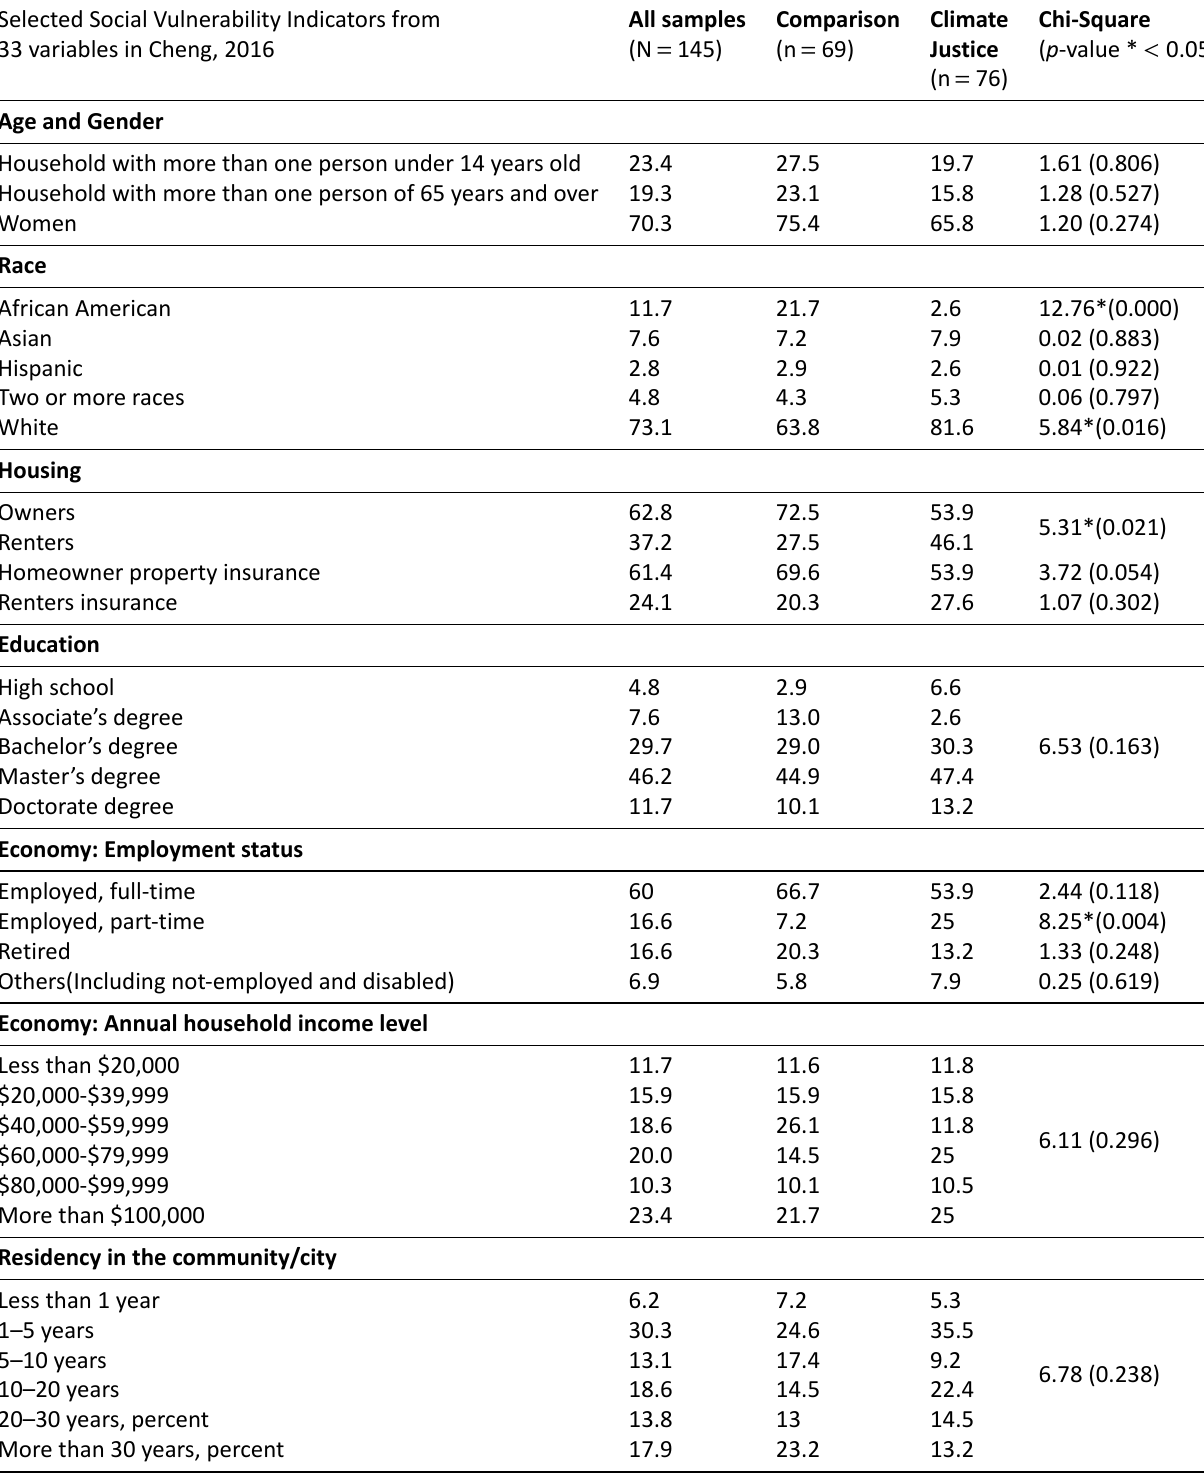
Table 2. Summary of demographics associated with social vulnerability comparing among all samples and two groups (Climate Justice areas and comparison